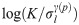
The compensated turbulent pair diffusion coefficient, log(K/σlγ(p)), against log(σl/η), for the same cases as in Fig 1, and with the same colour coding.For clarity some of the plots have been spaced out vertically, hence no scale is shown on the ordinate; this does not affect the scalings.